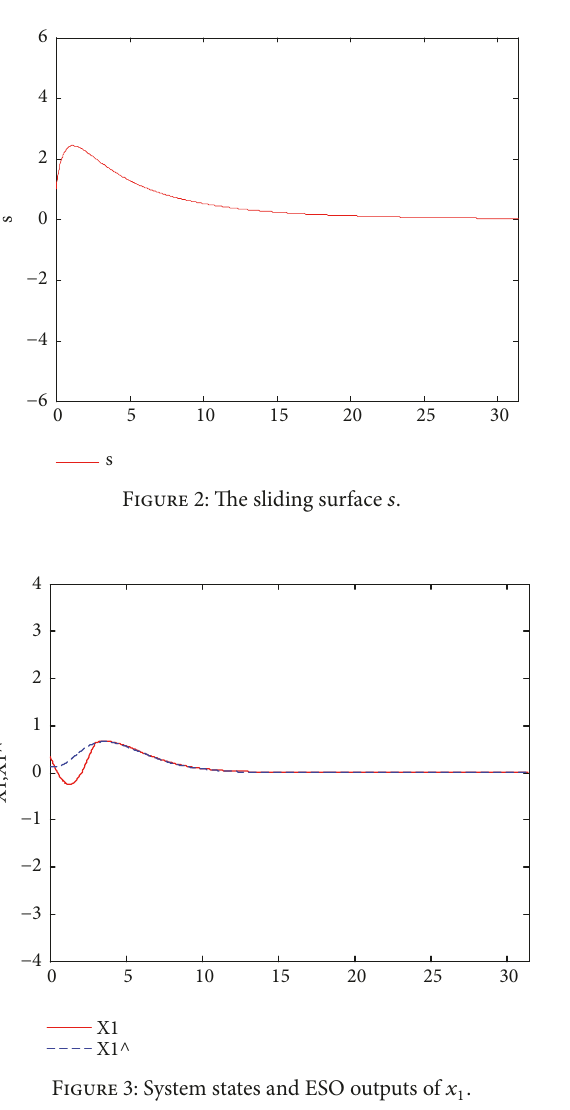
Figure 6: System states and ESO outputs of 𝑥 4 .